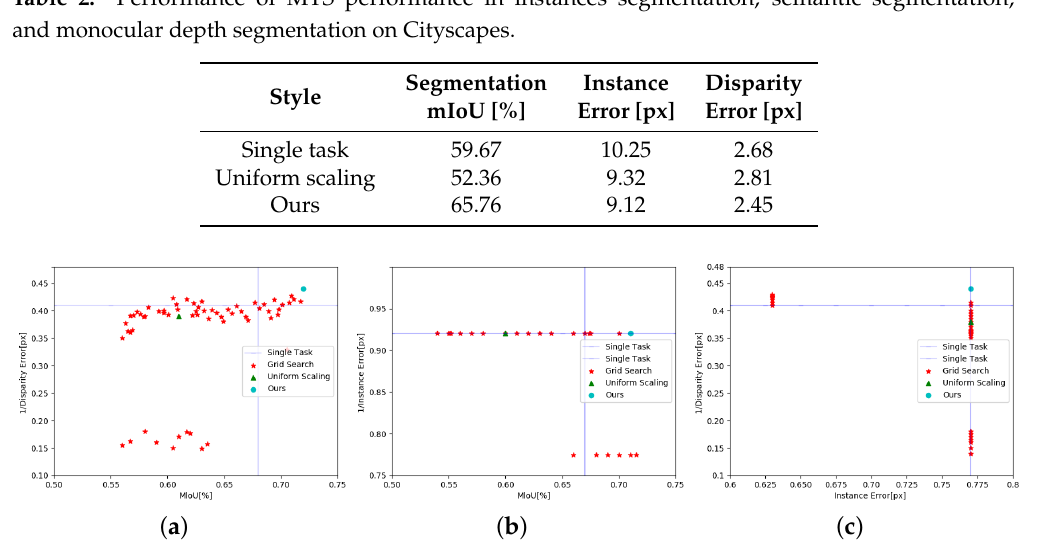
Figure 5. Scene realization experiment structure diagram.( a ) shows the performance of all baselines for semantic segmentation tasks;( b ) shows the performance of all baselines for instance segmentation tasks;( c ) shows the performance of all baselines for monocular depth segmentation